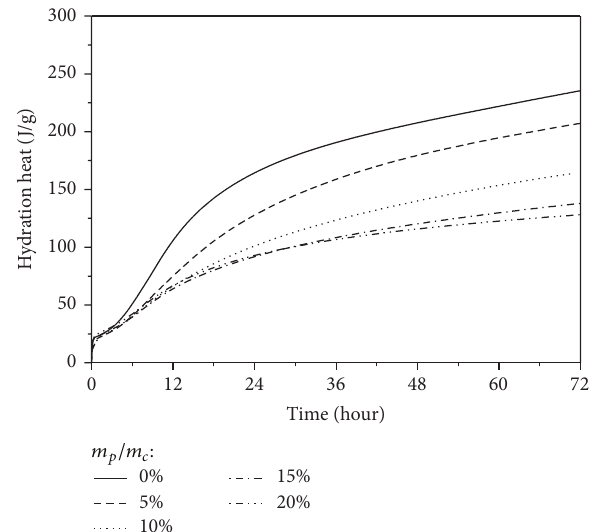
Figure 2: Hydration heat of cement in different 𝑚 𝑝 /𝑚 𝑐 .